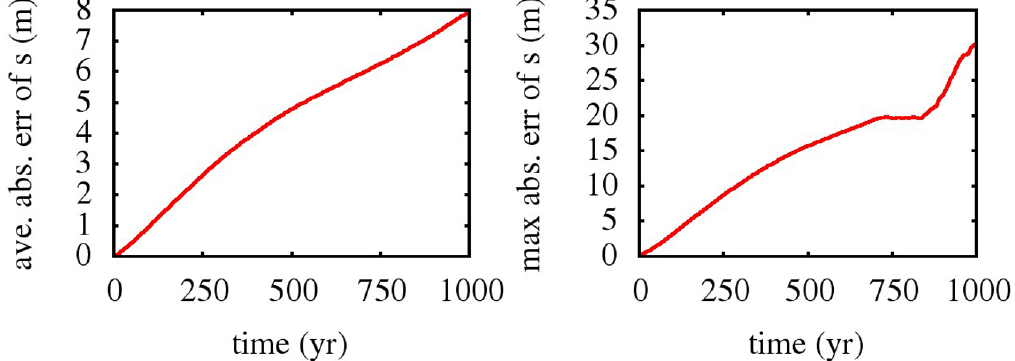
Fig. 5. Plot of the average (left) and the maximum (right) absolute errors of the simulated top surface elevation s (m) at each of the time steps for the time-dependent ice-sheet flow experiment using the grid of resolution 80 × 80 ×